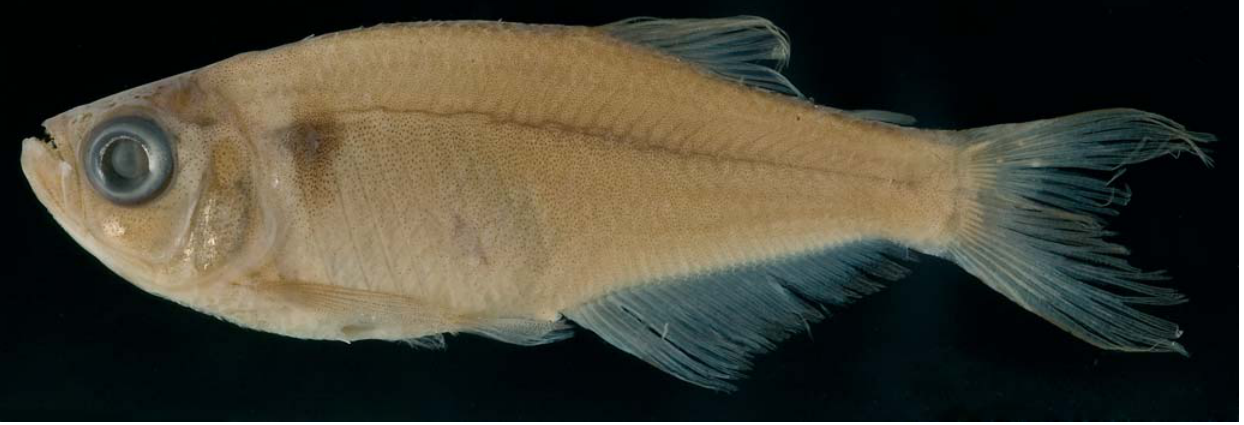
Fig. 30. Mimagoniates inequalis , female, MAPA 811, 22.7 mm SL, Brazil, Rio Grande do Sul, tributary to rio Gravataí at